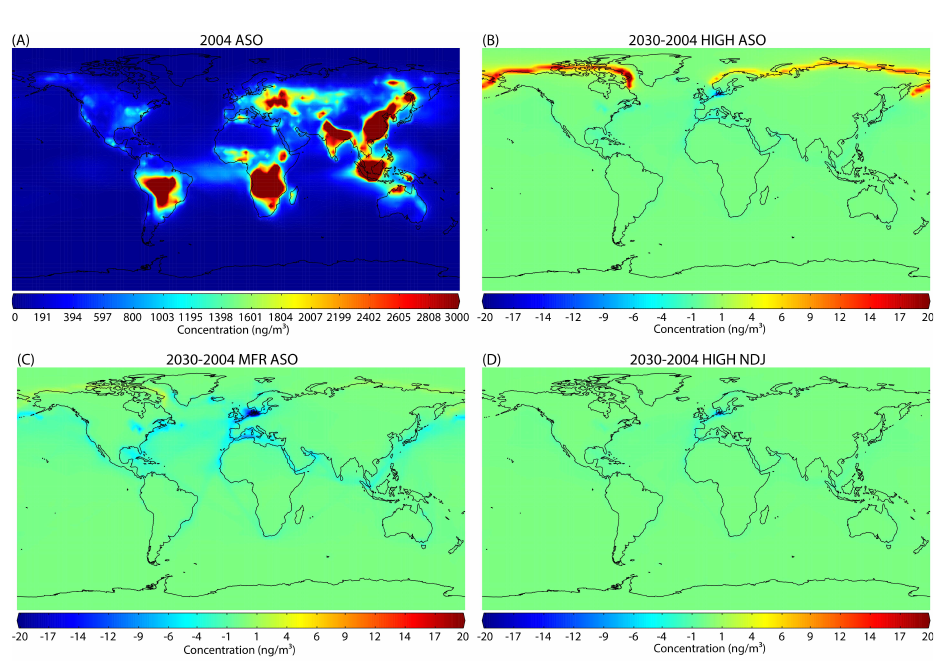
Fig. 5. Same as Fig. 3 for OC (ngm − 3 )